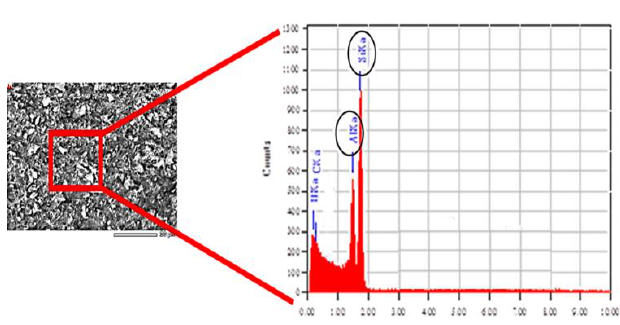
Fig. 3. SEM micrographs of 36. wt. % of super absorbent composites; (a-b) neat-clay (c-d) grafted-clay